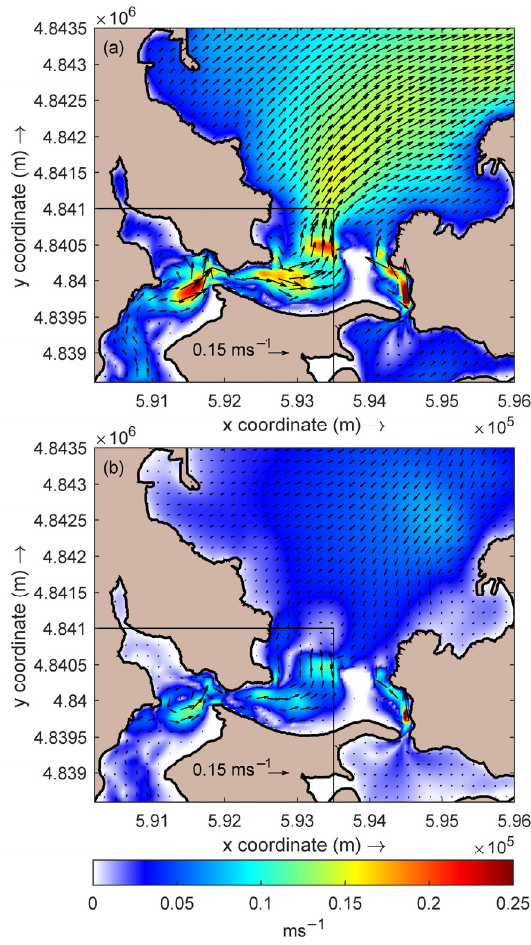
Figure 9. Residual flow pattern in Ria de Ortigueira under case study CS5 conditions. ( a ) Surface layer; ( b ) bottom layer.